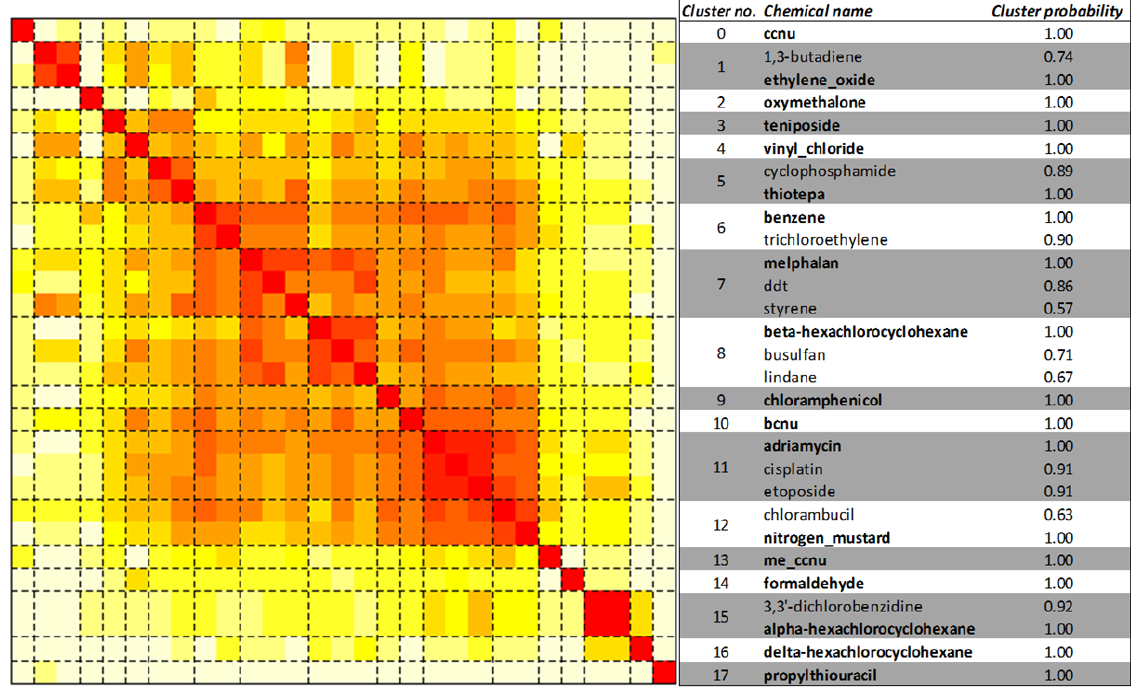
Figure 3. Unsupervised clustering of leukemogens. The 29 leukemogens are clustered based on the distance between rows (corresponding to the leukemogens) of the matrix of transformed pathway enrichment p values over all the 250 KEGG human pathways (corresponding to the columns). The figure is a visual representation of the distance matrix between all the chosen leukemogens. The color of the (i,j)th position of the distance matrix, where i , j represent indices in the set of 29 leukemogens indexed by values in the set {1, 2,…29}, is a measure of how close leukemogen i and leukemogen j are to each other based on the enrichment of their gene targets on all the KEGG human pathways. The color ranges from white to red, with red indicating greater closeness of leukemogen pairs. Dashed black lines indicate the boundaries of clusters of leukemogens as determined by the HOPACH algorithm [60]. Eighteen clusters, labeled from 0 to 17, were identified. Listed on the right are the chemical names, the medoid chemicals (or chemicals with pathway response pattern most similar to other chemicals in the cluster) for each cluster identified in bold case, and the cluster membership probabilities of each of the